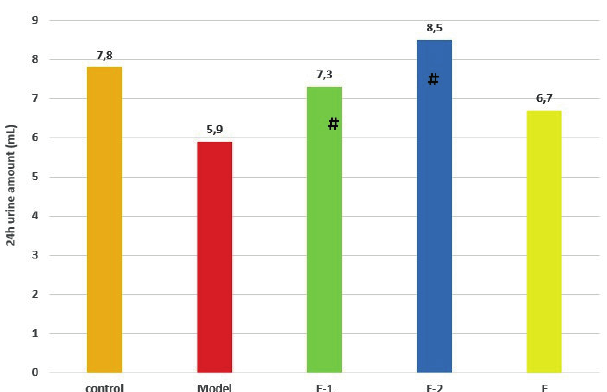
FIGURE 4 - Effect on 24 h urine amount. Model: BPH, E-1: Extract-30 mg/kg, E-2: Extract-60 mg/kg, F: Finasteride- 10mg/kg. The data were stated as mean ± SE. Superscript sign shows significant difference: #–from Model, #p <